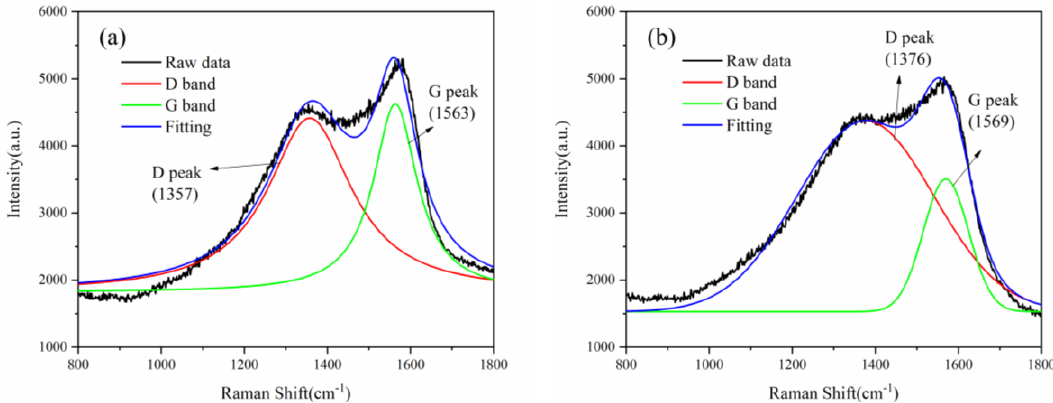
Figure 4. Raman spectrum: ( a ) TD film ( b ) TTTD